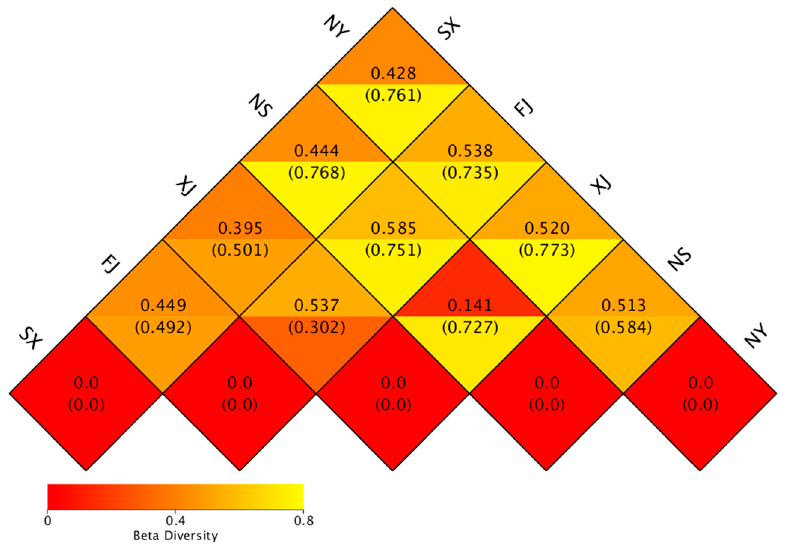
Figure 7. Heat map of the Beta diversity index for all samples.